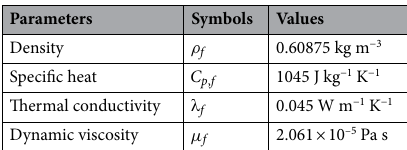
Table 2. Thermo-physical properties of air at 573 K 35 .